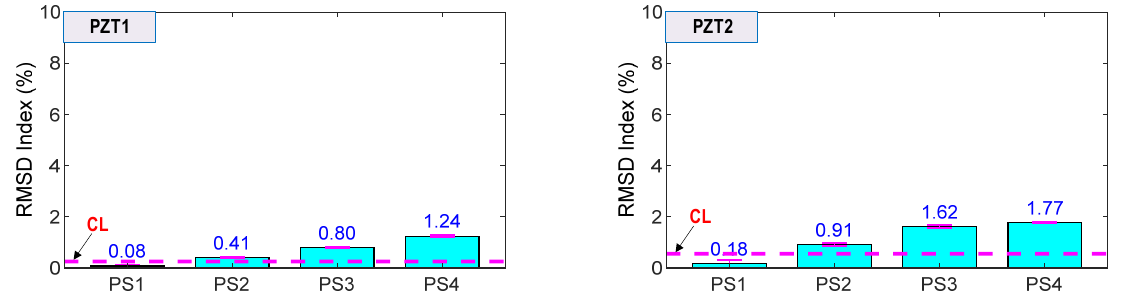
Figure 23. RMSD indices of impedance signals via smart aggregates under loading cases PS1~PS4: ( a ) Smart aggregates AG.1-1 and AG.1-2; ( b ) Smart aggregates AG.2-1 and AG.2-2.